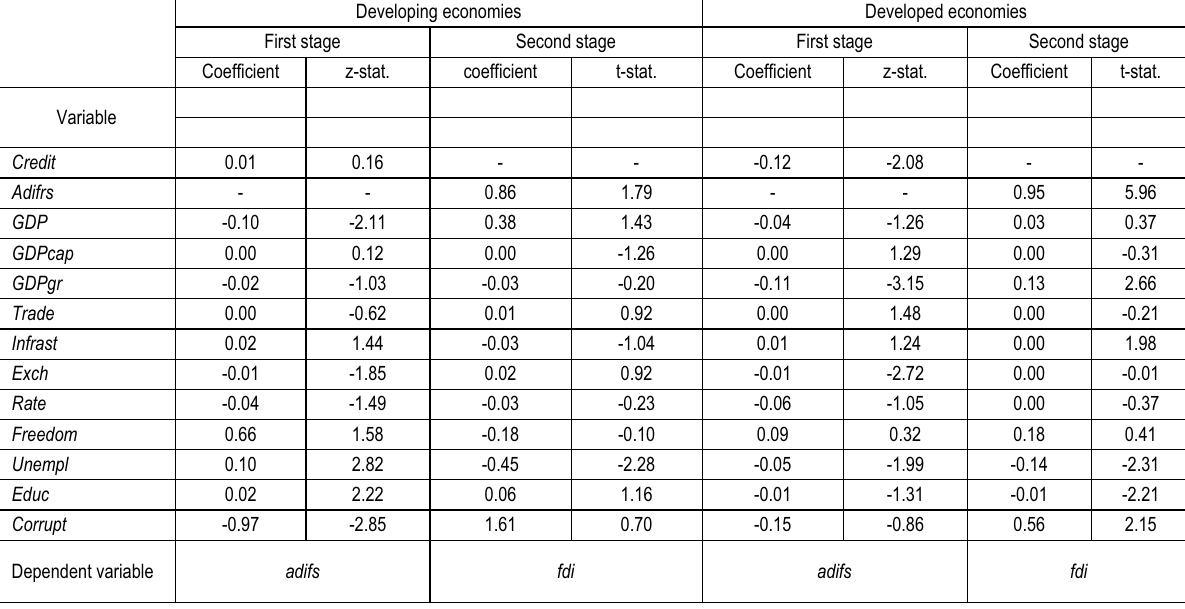
Table 3. Instrumental variables estimation-credit